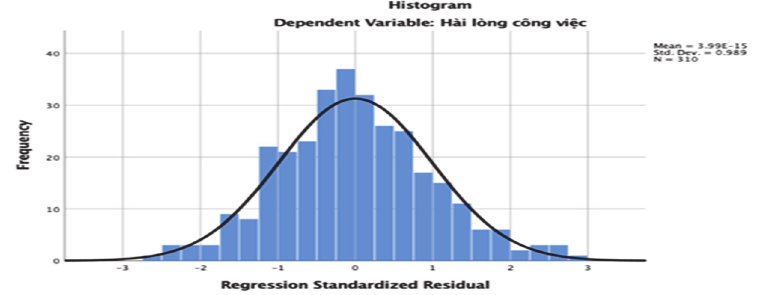
Fig. 1. Distribution of